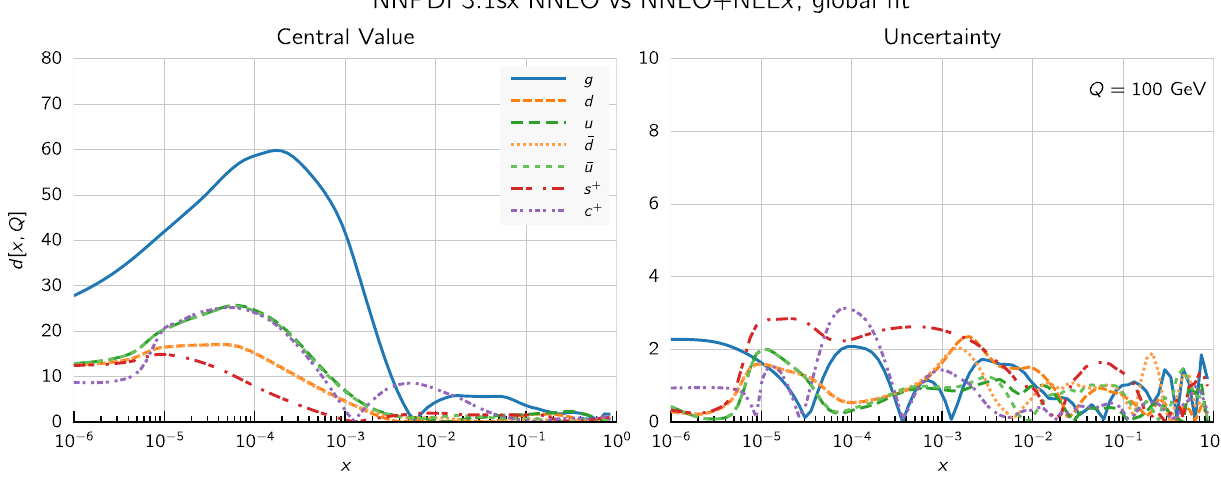
Fig. 14 Same as Fig. 10 for the NNPDF3.1sx global fits